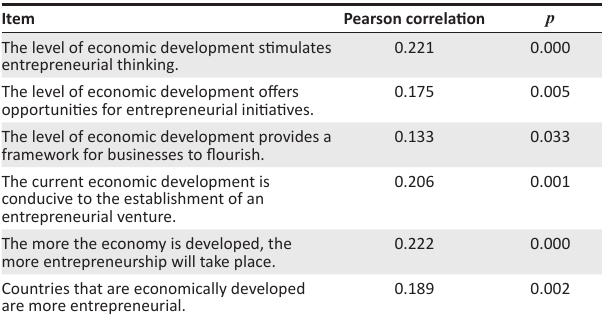
TABLE 10: Correlation between economic development and entrepreneurial